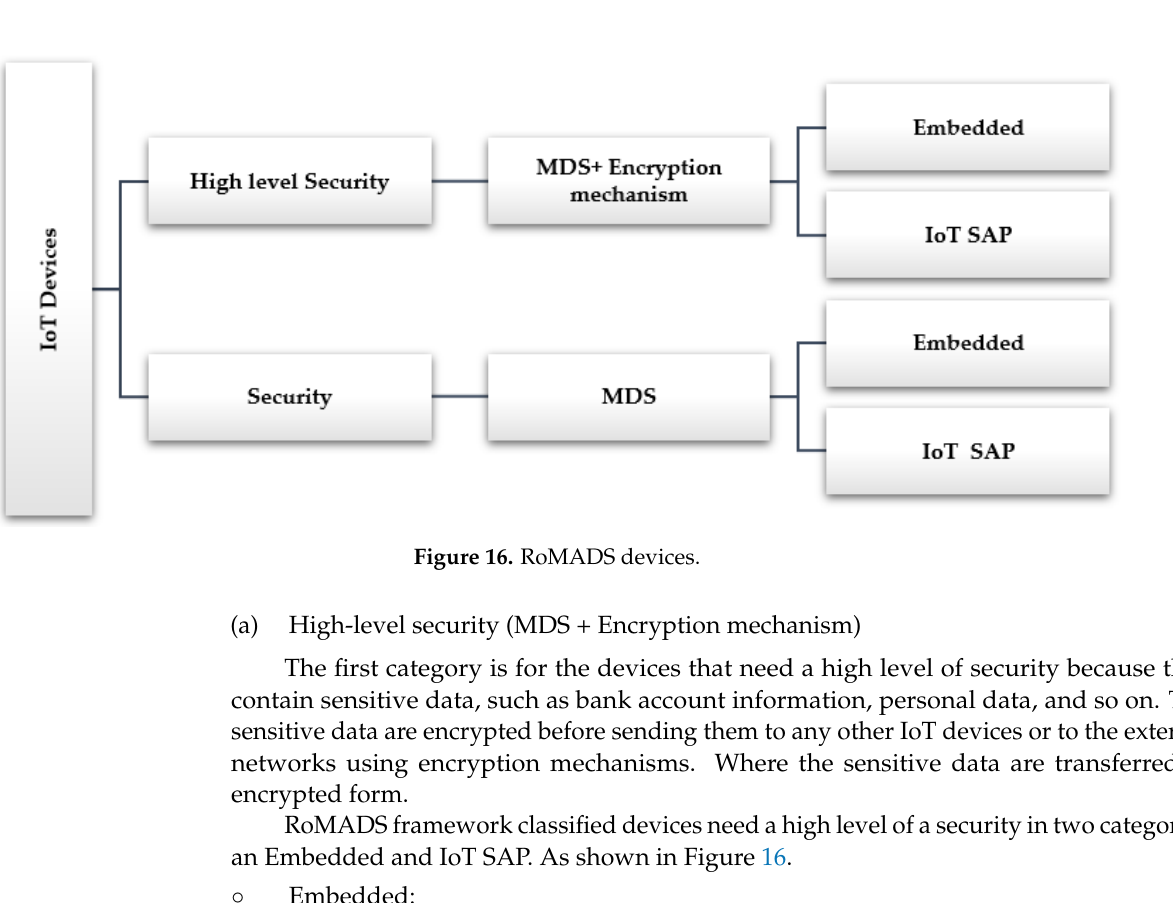
Figure 16. RoMADS devices.